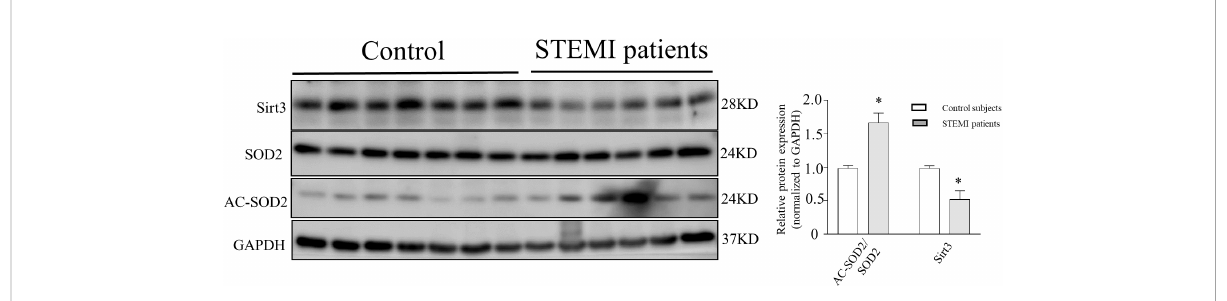
FIGURE 7 Representative western blots of SOD2 acetylation, SOD2, and Sirt3 expression in PBMCs of STEMI subjects and control subjects. Representative western blots of SOD2 acetylation, SOD2, and Sirt3 expression in STEMI patients compared with that in control subjects. Human peripheral blood mononuclear cells (PBMCs) were obtained from STEMI patients and control subjects. SOD2 acetylation was measured using anti-acetyl- SOD2, *:P < 0.05 vs. control